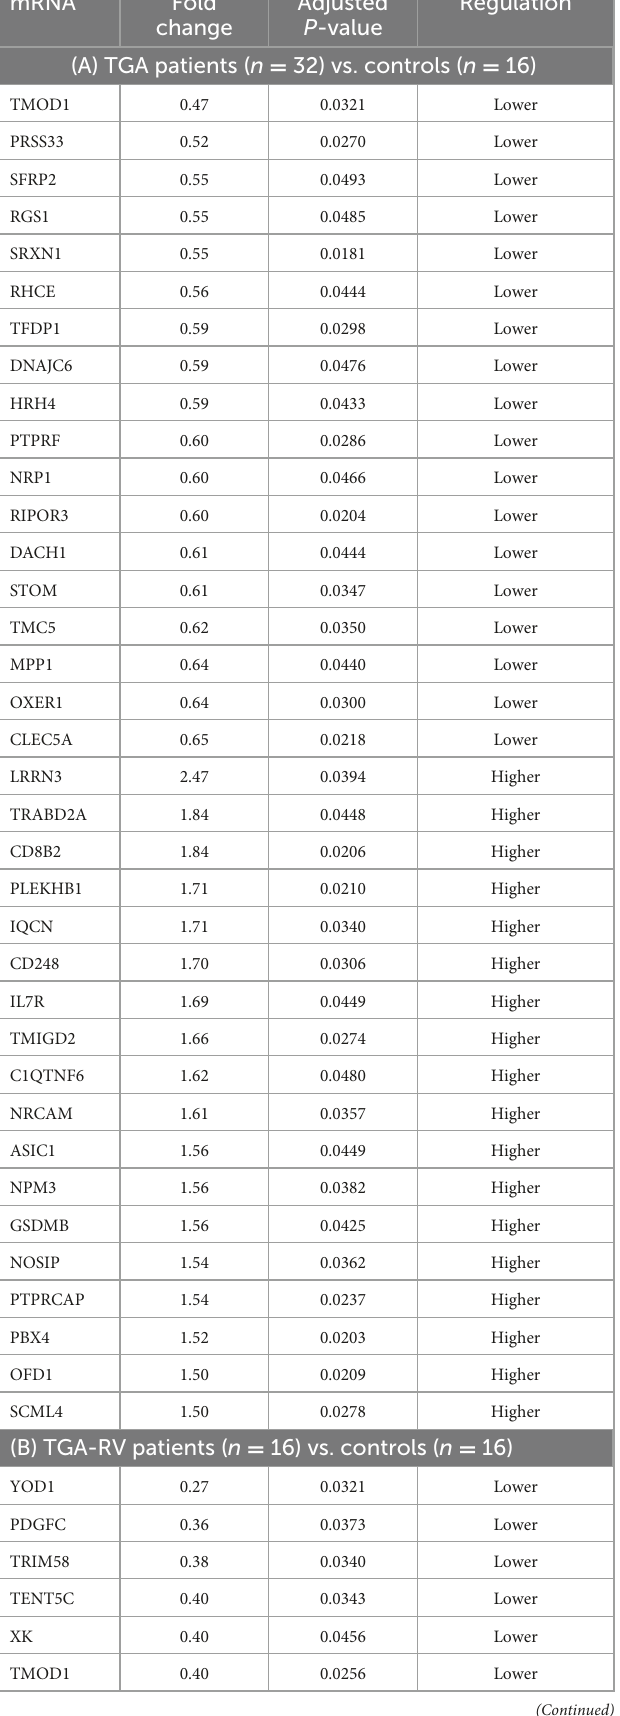
TABLE 3 Significantly abundant mRNAs in the blood of TGA patients compared to controls as determined by microarray. mRNA Fold Adjusted change P -value